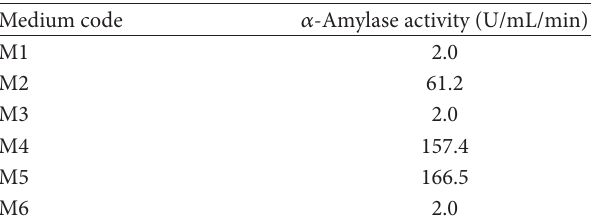
-amylase activity by Bacillus 𝛼𝛼